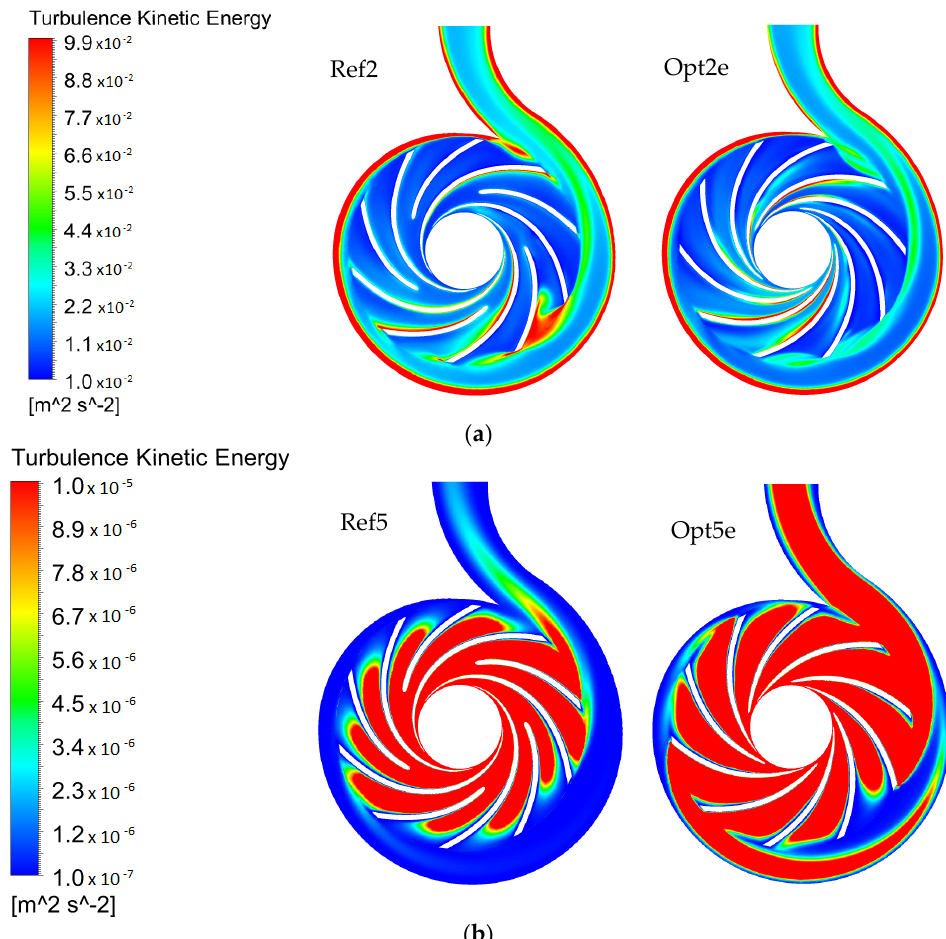
Figure 22. Velocity at the vortex core region of the reference and optimized impeller: ( a ) C1 and ( b ) C4.